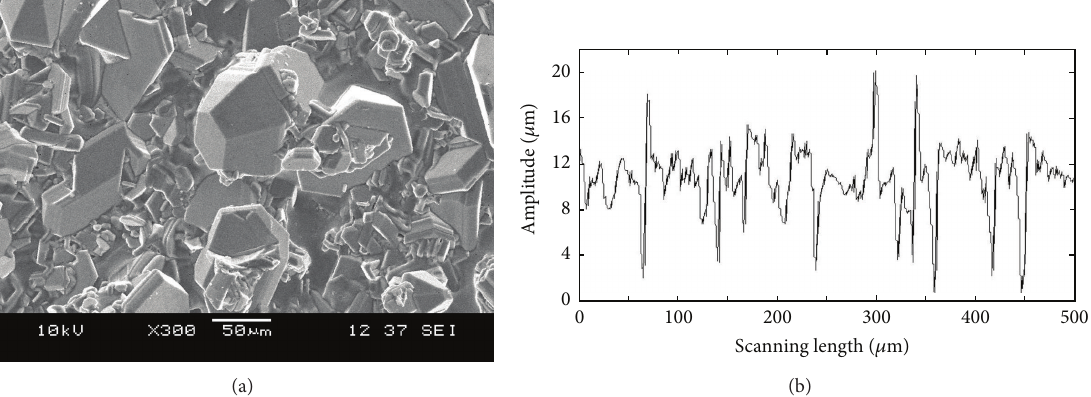
Figure 3: (a) SEM micrograph and (b) surface roughness curve of the SiC interlayers.